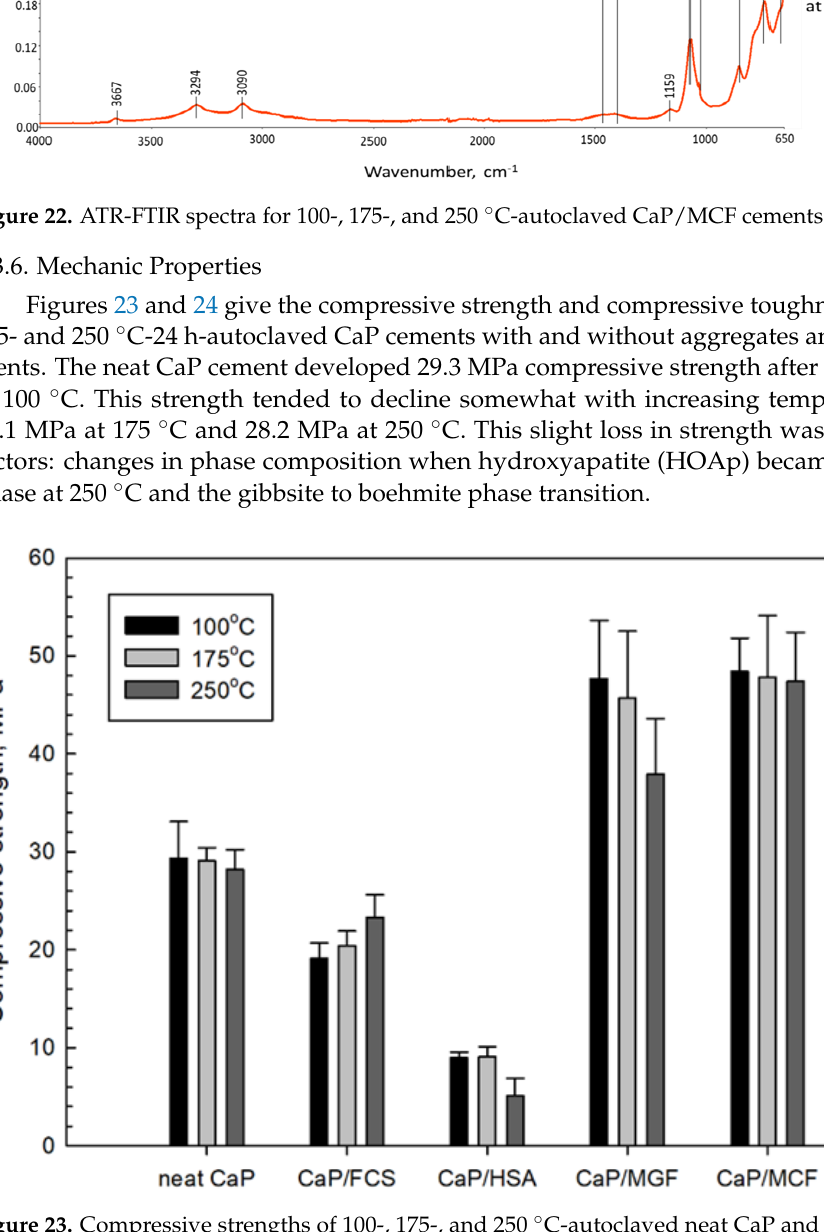
Figure 22. ATR-FTIR spectra for 100-, 175-, and 250 °C-autoclaved CaP/MCF cements.